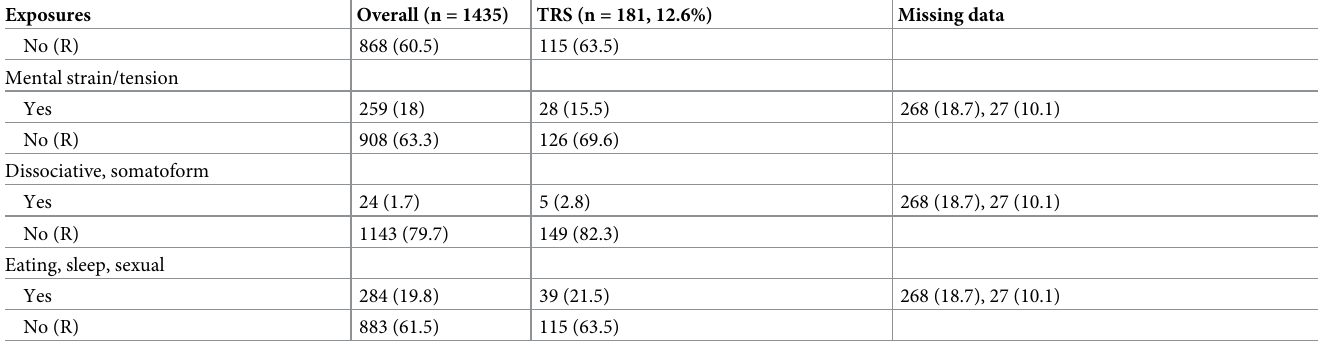
years. S2 Table summarises the validated estimates of the model’s performance- for example at 2 years the model achieved a validated PPV 0.04 (prevalence at 2 years was 0.02); NPV 0.98; sensitivity 0.60; specificity 0.63. Table 2 displays estimated Lasso coefficients for all 31 potential predictors (47 main effect parameters). Seven variables were selected as predictors of TRS in the Lasso-Cox model (corre- sponding to the 1 SE penalty): having more inpatient days in the three months before and after the first antipsychotic; having more community face-to-face clinical contact in the three months before the first antipsychotic; having a minor cognitive problem requiring no action